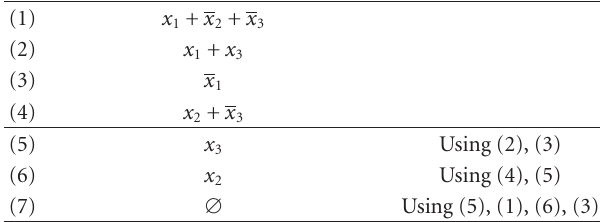
Table 1: Resolution proof